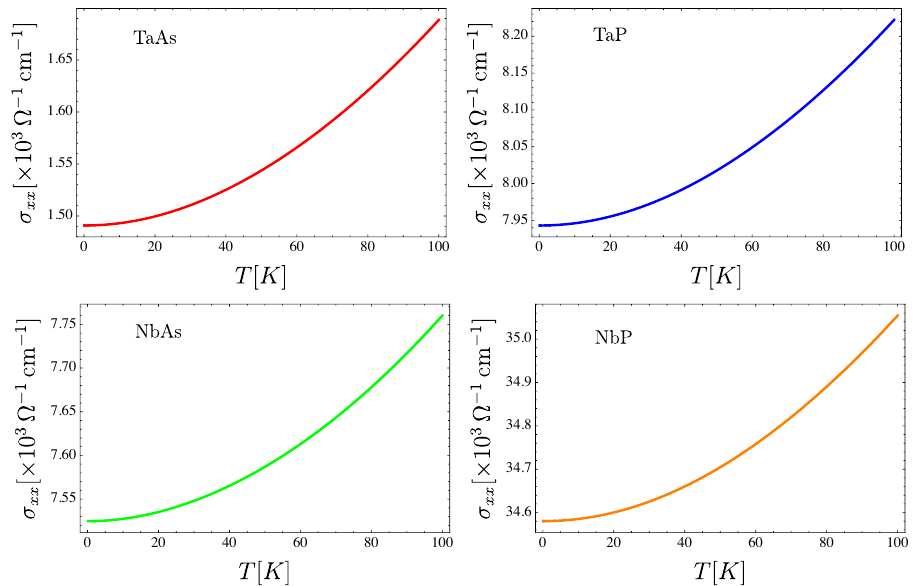
Figure 8. The total conductivity vs. temperature behavior for the transition metals monopnictides TaAs, TaP, NbAs, and NbP. Here, we use a concentration of dislocations of n d = 10 11 cm − 2 . Now, let us study the conductivity behavior with respect to the density of disloca- tions n d . In Figure 9, we present a plot of the natural logarithm of the conductivity versus temperature for three different concentrations of